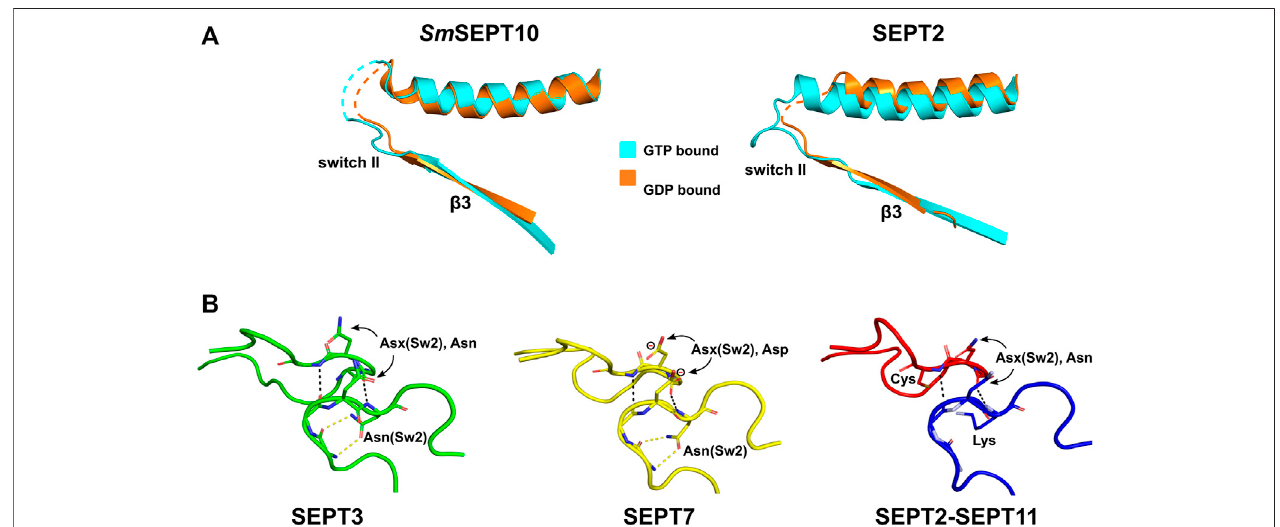
FIGURE 8 | Switch II diversity at the G-interface. (A) β -slippage of the β 3-strand in Sm SEPT10 and SEPT2. After GTP hydrolysis, the β 3-strand slides in the direction of the G-interface, which prevents the formation of the correct contacts between the two copies of switch II (the β -bridge). PDB:4KVA (left; GTP, cyan), PDB: 4KV9 (left; GDP, orange), PDB:3FTQ (right; GMPPNP, cyan), PDB:2QNR (right; GDP, orange). (B) The β -bridge (characterized by the hydrogen bonds shown as black dashed lines) in homotypic and heterotypic G-interfaces. Asx(Sw2) residues, conserved in septins, are paired across the interface. In SEPT7, this position is an asparticacid(formalchargedisplayed).Anasparagineresidue,Asn(Sw2),conserved intheSEPT3andSEPT7groups,formshydrogenbonds(yellowdashedlines)with the main chain, helping to stabilize the β -bridge. A lysine substitutes this aspargine in the SEPT6 group and cysteines appear in this position in SEPT1 and SEPT2, suggesting a new mechanism to stabilize the β -bridge in these cases. SEPT3, PDB:4Z54; SEPT7, PDB: 6N0B; SEPT2-11, PDB:6UPQ.